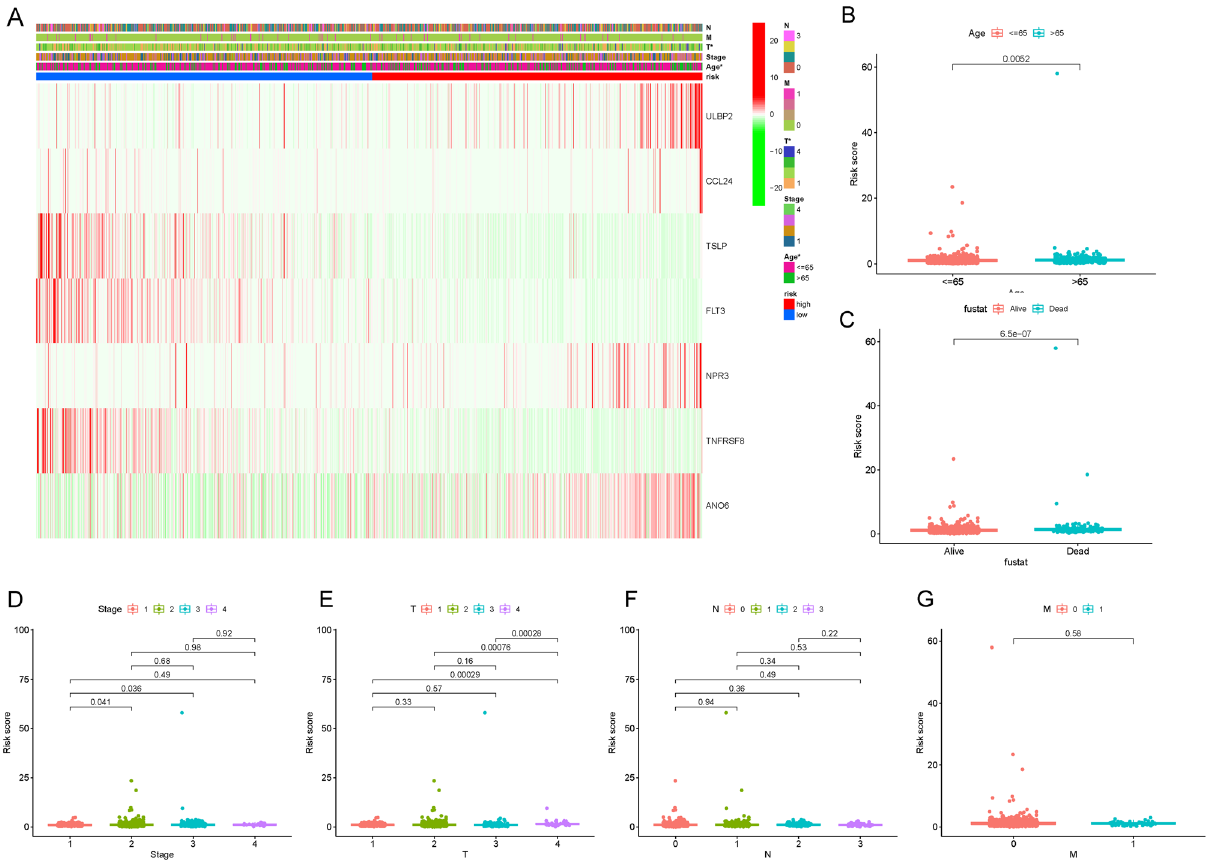
Figure 5. The correlation of the risk score with the clinical characteristics in the training cohort of breast cancer (BC) patients. ( A ) The heatmap displays the correlation of the 7 immune-related genes (IRGs) in our model with BC clinical characteristics. The correlation of the prognostic model with BC clinical characteristics [including tumour-node-metastasis (TNM), pathological stage, and age] between high- and low-risk groups was explored by the “limma” and “ggpubr” R packages. ( B , C ) The risk score was higher in BC patients aged > 65 years and those with adverse outcomes. ( D – G ) The risk scores of BC patients with different clinical stages and TNM stages were also significantly different. BC breast cancer, IRG immune-related gene, TNM